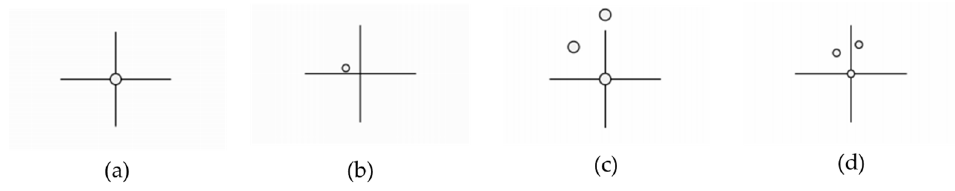
Figure 2. Principle of star method. ( a ) Visible star point; ( b ) Infrared star point; ( c ) Visible star points; ( d ) Infrared star points.